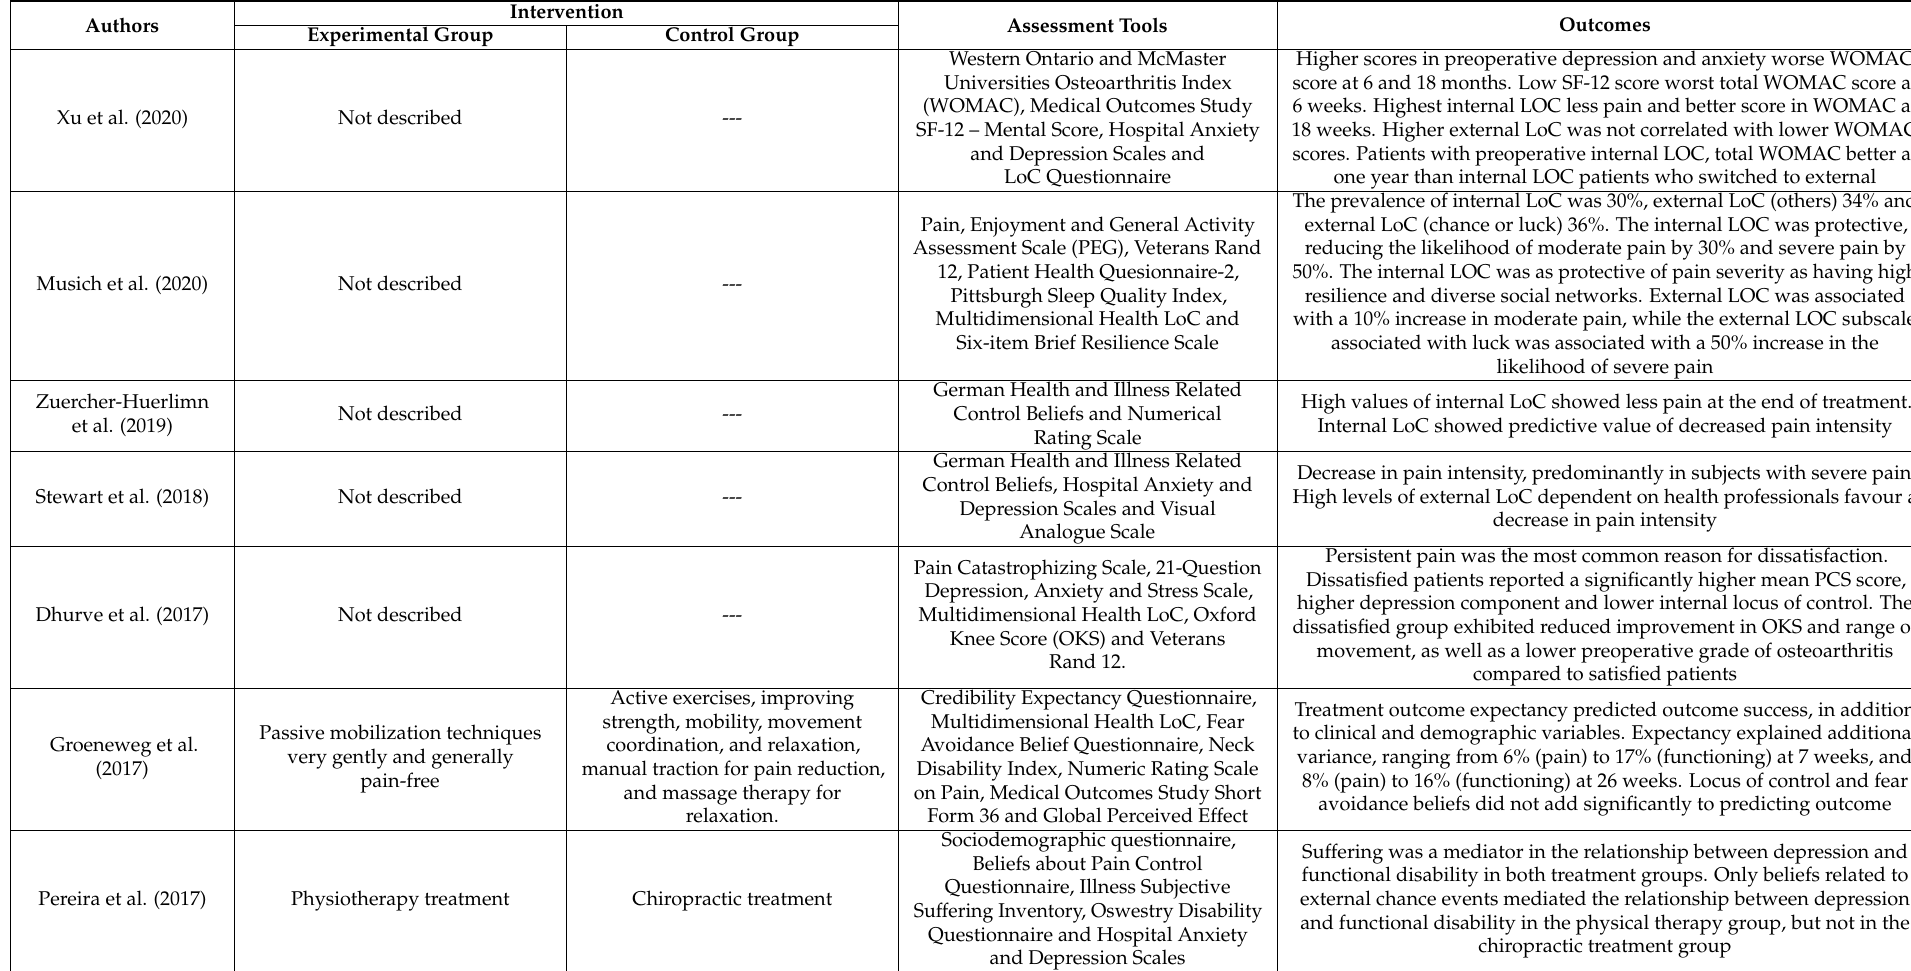
Table 3. Characteristics of the interventions of the studies